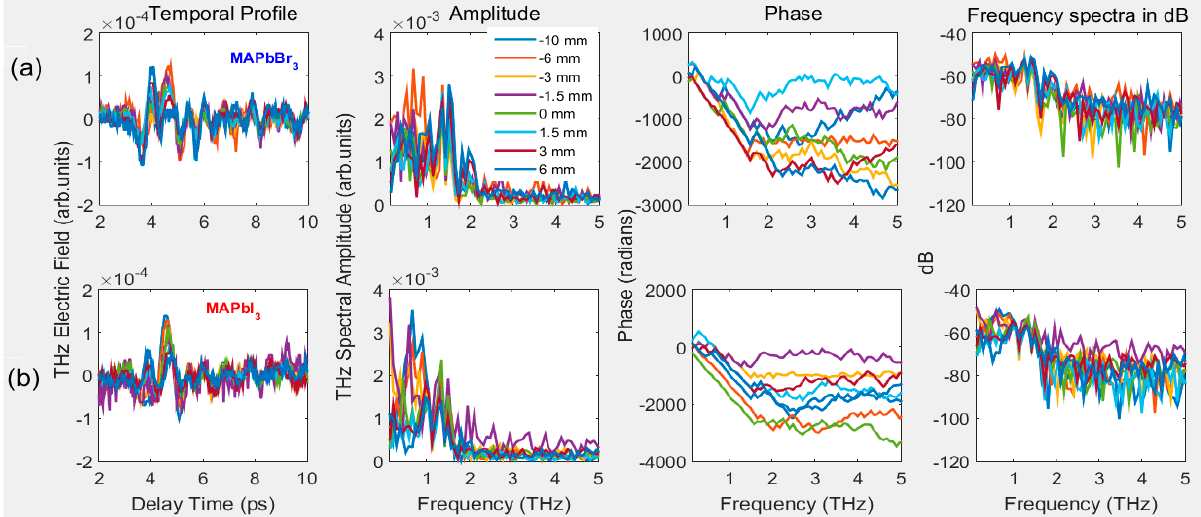
Figure 6. Temporal profile, amplitude, phase, and frequency spectra of ( a ) MAPbBr 3 and ( b ) MAPbI 3 PSCs. The samples moved along the Z -axis near the focal area of PM2 between -10 mm and 10 mm.